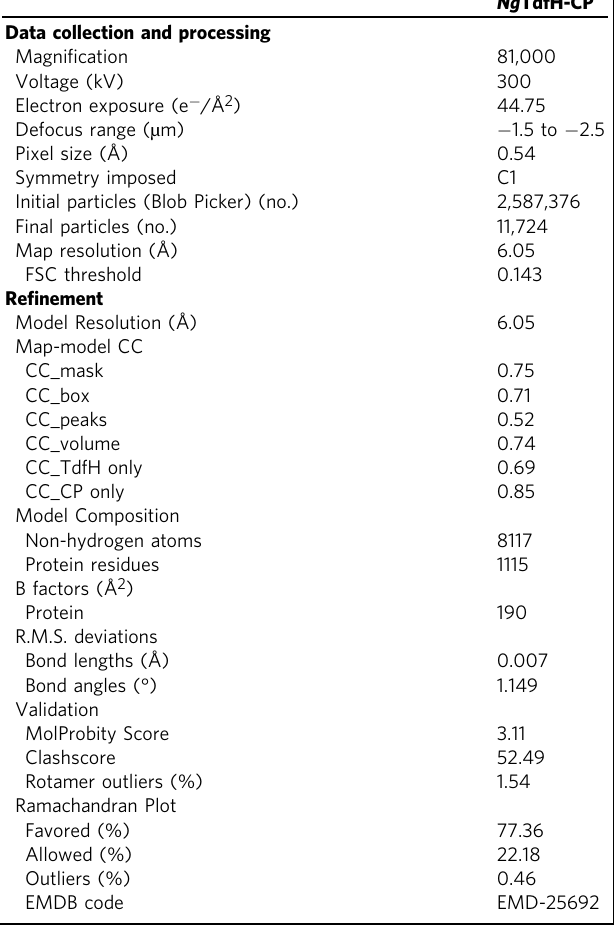
Table 1 CryoEM data collection and re fi nement